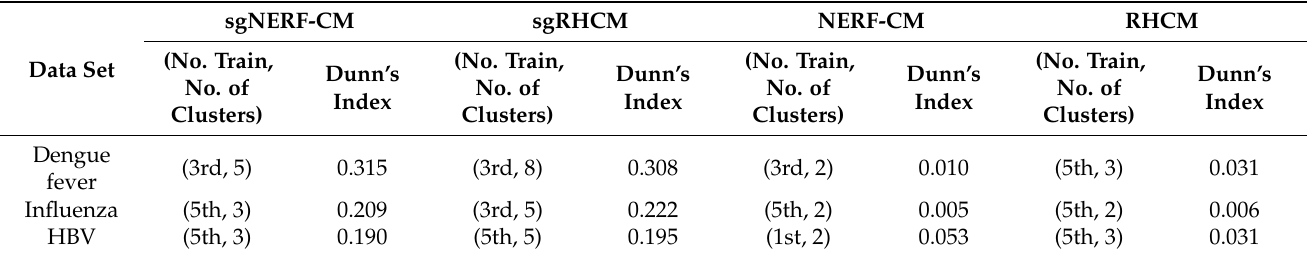
Table 8. The best result from month